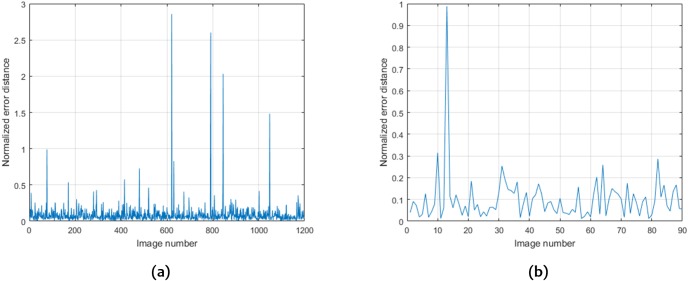
Values of \documentclass[12pt]{minimal}
\usepackage{amsmath}
\usepackage{wasysym}
\usepackage{amsfonts}
\usepackage{amssymb}
\usepackage{amsbsy}
\usepackage{upgreek}
\usepackage{mathrsfs}
\setlength{\oddsidemargin}{-69pt}
\begin{document}
}{}${D}^{\ast } \left( {c}_{\mathrm{exp}},{c}_{\mathrm{real}} \right) $\end{document}D∗cexp,creal obtained for the Messidor (A) and ONHSD (B) datasets.